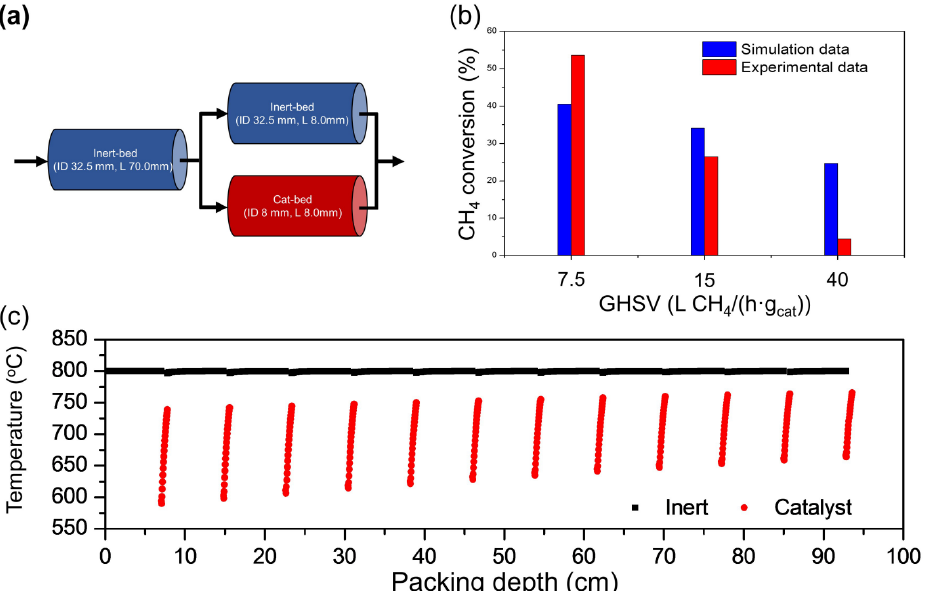
Figure 6. ( a ) Schematic of the bench-scale reactor (hydraulic diameter of the catalyst pellet was used in the Cat-bed module), ( b ) comparison of the CH 4 conversion for various space velocities [mL CH 4 / (h · g cat )], and ( c ) temperature profile in the reactor at 7.5 L CH 4 / (h · g cat ). Wall temperature = 800 ◦ C, pressure = 0.6 MPa, overall heat transfer coe ffi cient = 100 W / (m 2 · K), and feed composition of CH 4 / H 2 O / N 2 = 1 / 3 / 1.